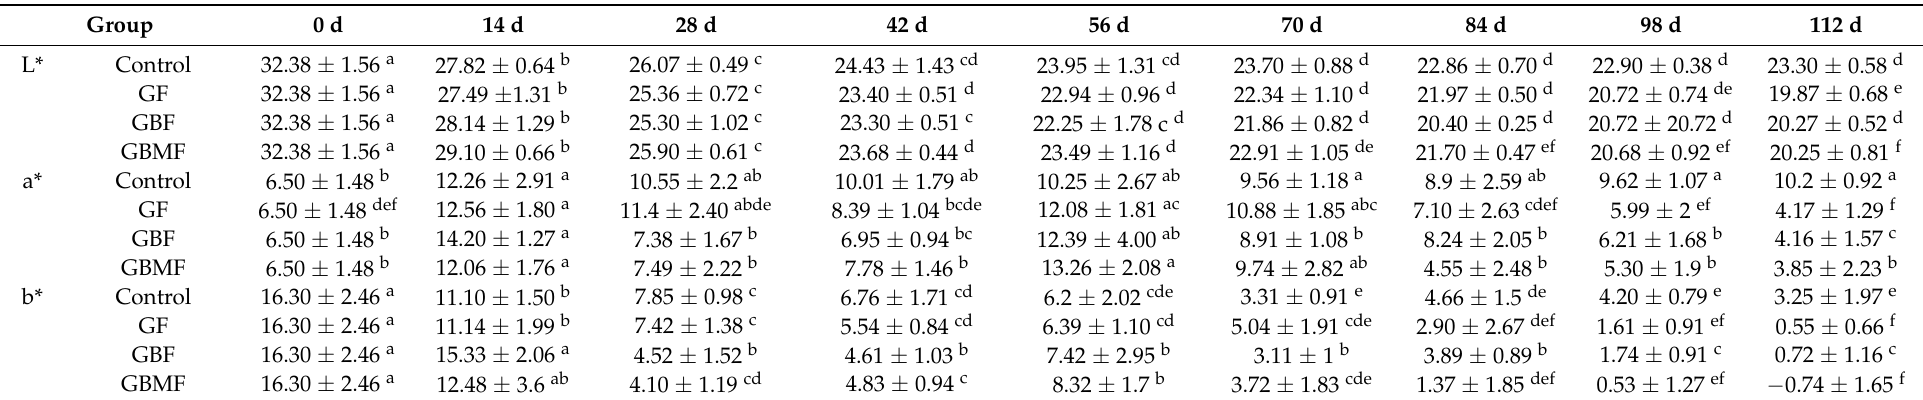
Table 4. Changes in the color of the preserved egg white coated with different films.